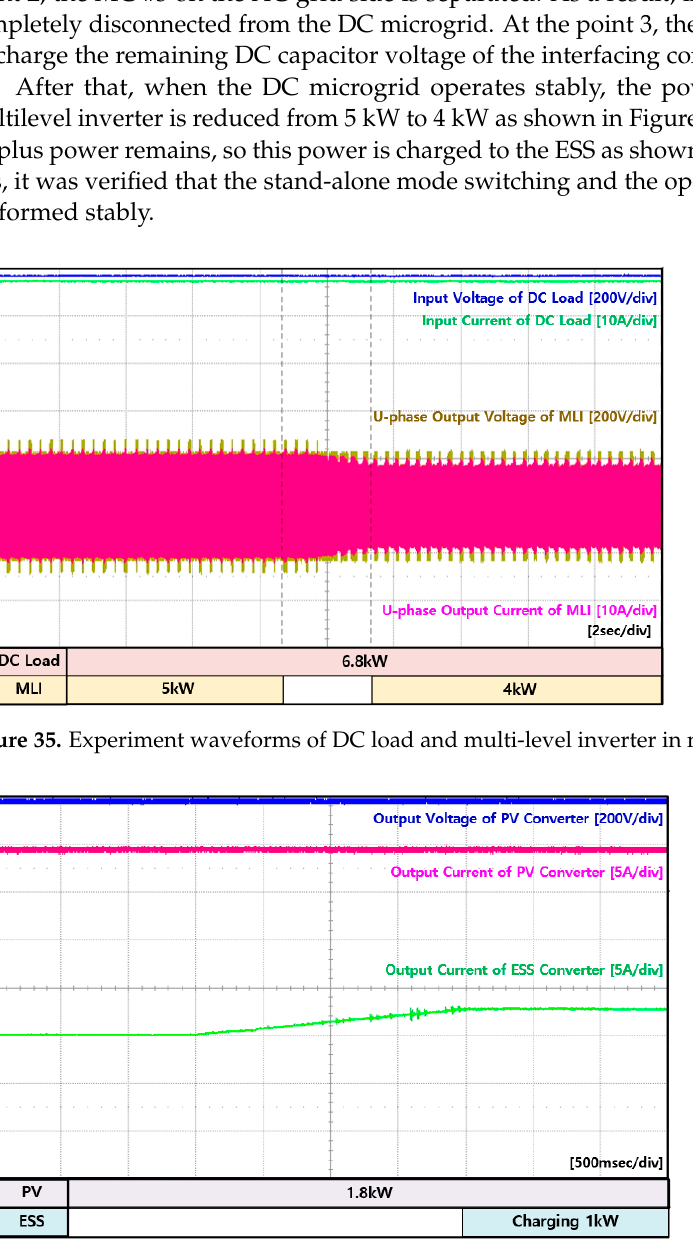
Figure 34. Experiment results of mode transition from grid-connected mode to stand-alone mode